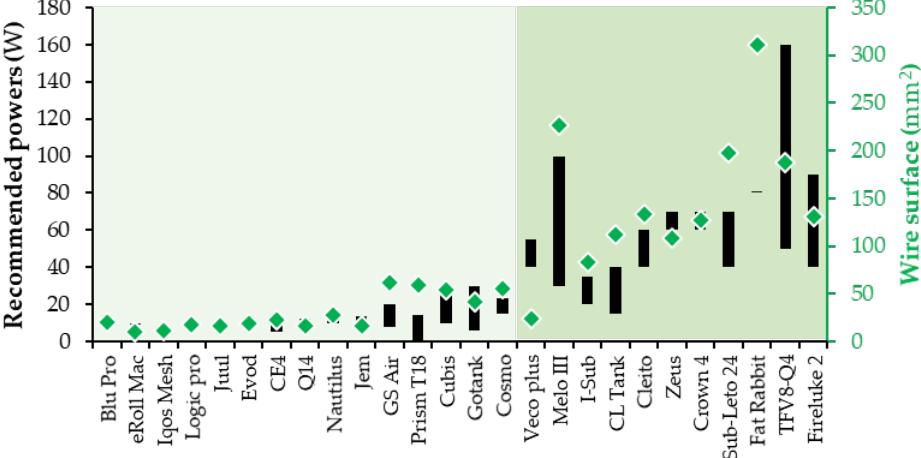
Figure 10. Recommended powers of the twenty-six tested devices regarding their surfaces. The wire surface have a wide range of values (between 10 and 350 mm 2 ). Therefore, fifteen surfaces are between 10 and 62 mm 2 with nine values between 10 and 27 mm 2 . In the other side, ten ones are upper than 80 mm 2 and are more dispersed. An average surface limit between 62 and 80 mm 2 is 71 mm 2 . Additionally, wire surface and recommended powers looks correlated. In thermal problem, heat flux expresses the ratio between a power and the heat surface and characterizes the heat transfers. Following this observation, Figure 11 shows the average heat flux determined using the average recommended power and the heat flux range represented as a deviation.